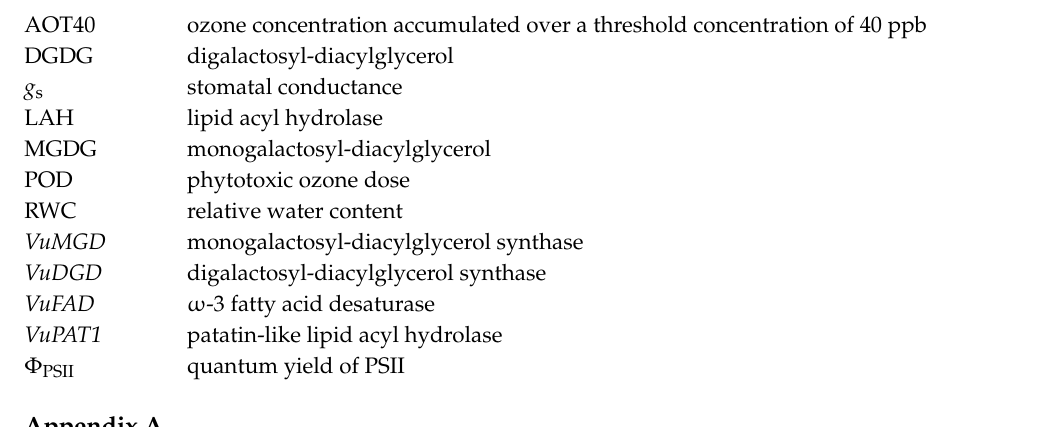
Figure A1: Detection of hydrogen peroxide using DAB staining; Table A1: MGDG and DGDG fatty acid composition; Table A2: Analysis of variance (ANOVA) of physiological parameters; Table A3: Analysis of variance (ANOVA) of lipid contents; Table A4: Analysis of variance (ANOVA) of gene expression data; Table A5: Description of genes analyzed by